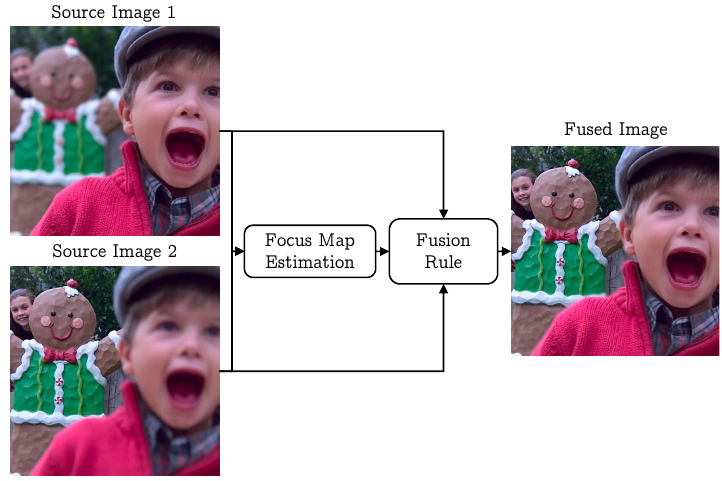
Figure 1. General image fusion process using two multi-focus